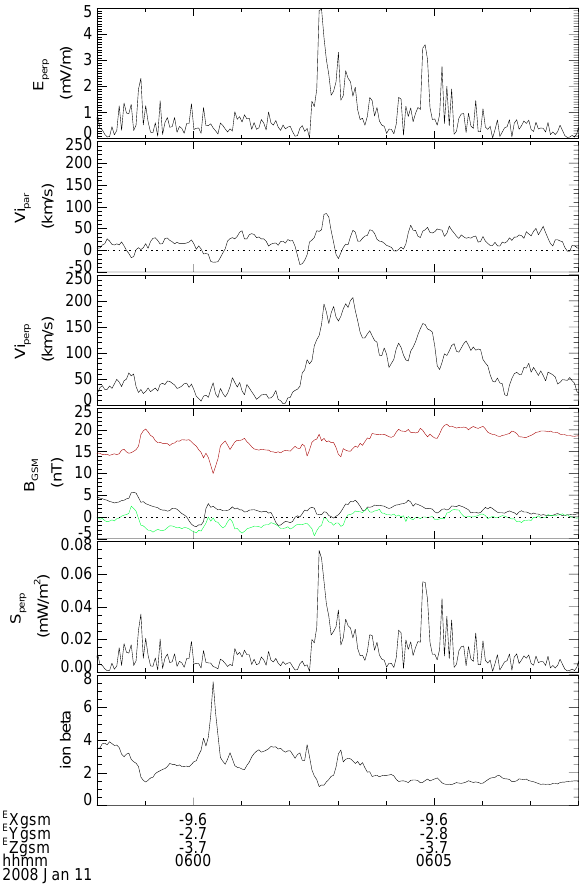
Fig. 3. The three GSM components of electric field for the same event as Fig. 1 but zoomed in at 05:58–06:08UT. The black lines are measurements by the EFI instrument, where the third component has been calculated by assuming E · B = 0. The dotted green lines are − v × B . The total velocity of the ion flow is repeated in the fourth panel.